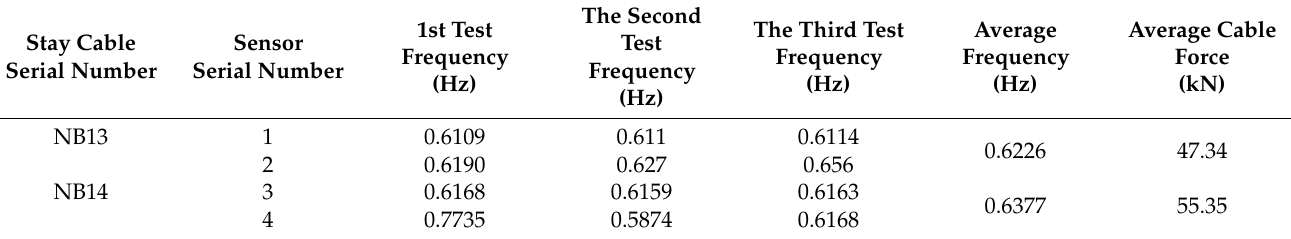
Table 2. Frequency test results under artificial excitation.